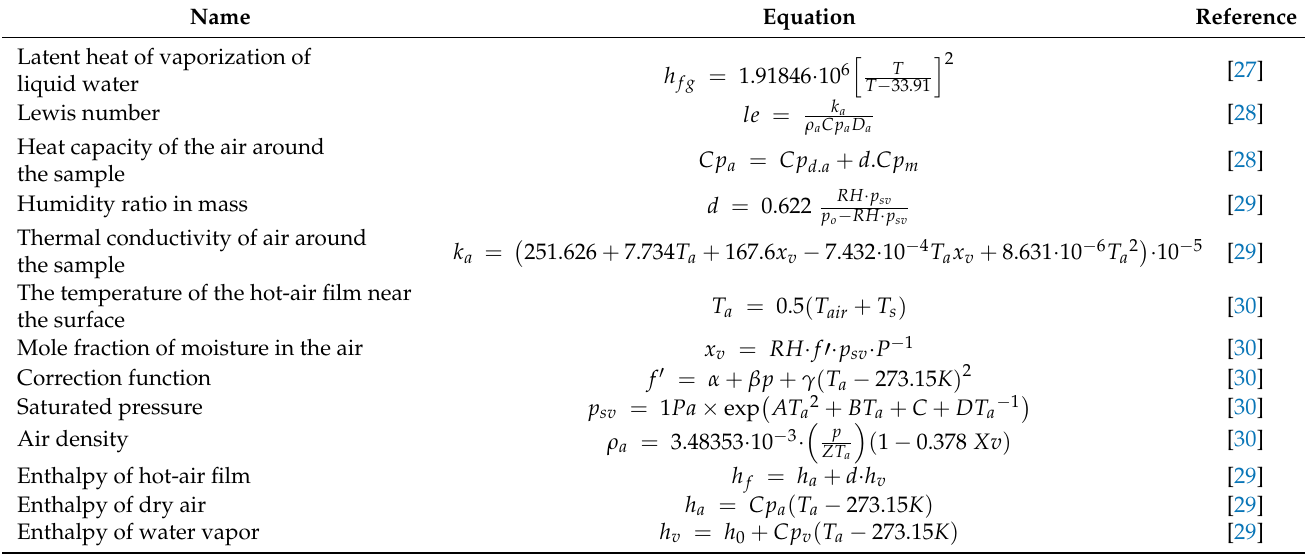
Table 1. Equations used to calculate the numerical parameters for the Lewis